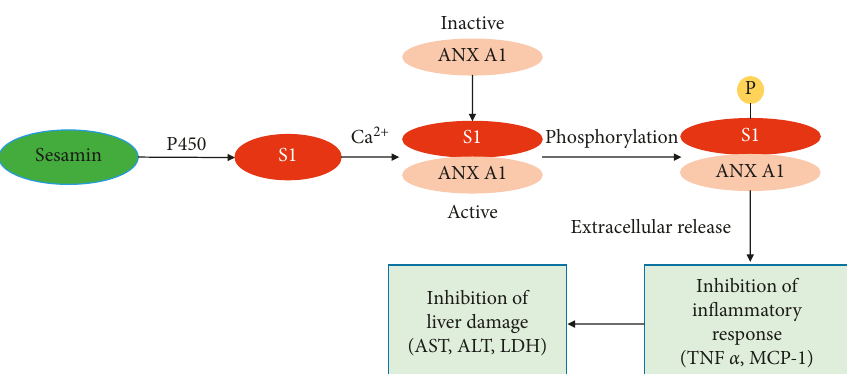
Figure 4: Schematic of the anti-inflammatory effect of S1 mediated by ANX A1 activation. S1 directly binds to the repeat 3 domain of ANX A1 in monocytes. Under stimulation, S1 promotes the phosphorylation of ANX A1 Ser27 and the subsequent extracellular release of ANX A1 and inhibits the production of TNF- α or MCP-1 to exert anti-inflammatory